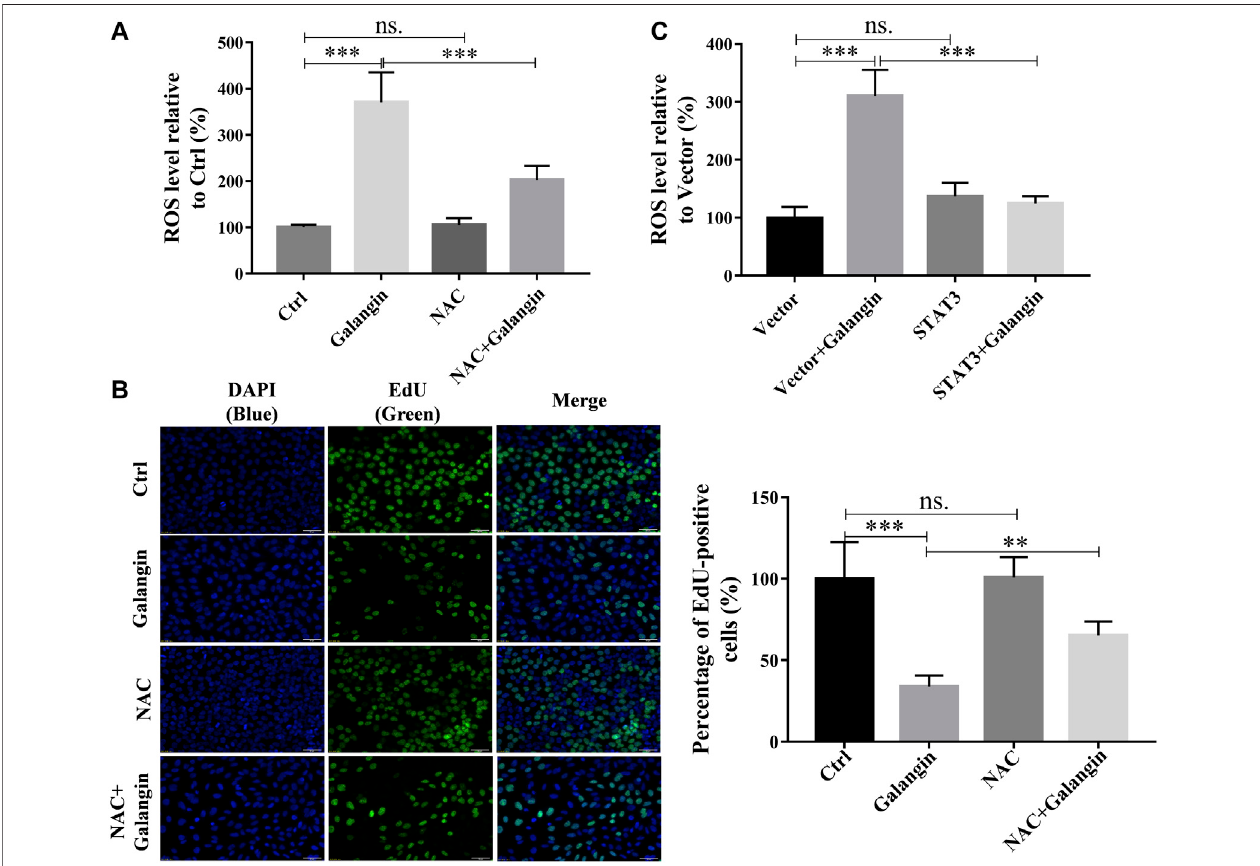
FIGURE8| TheinhibitionofgalanginoncellproliferationisassociatedwithROSgeneration. (A) NAC(ROSscavenger)abolishedtheenhancedROSaccumulation in MGC 803 cells induced by galangin (20 μ M) after treatment for 48 h. (B) NAC counteracted the inhibited cell proliferation induced by galangin (20 μ M) after treatment for48 hdetectedbyEdUstaininginMGC803cells. (C) STAT3overexpressionreversedtheenhancedROSaccumulationinMGC803cellsinducedbygalangin(20 μ M) after treatment for 48 h. All of the data were shown as mean ± SD, and differences among ≥ 3 groups were analyzed by one-way ANOVA with Tukey test by using GraphPad 7.0 software; ** p < 0.01; *** p < 0.001. n ≥ 3. Scale bar: 50 μ